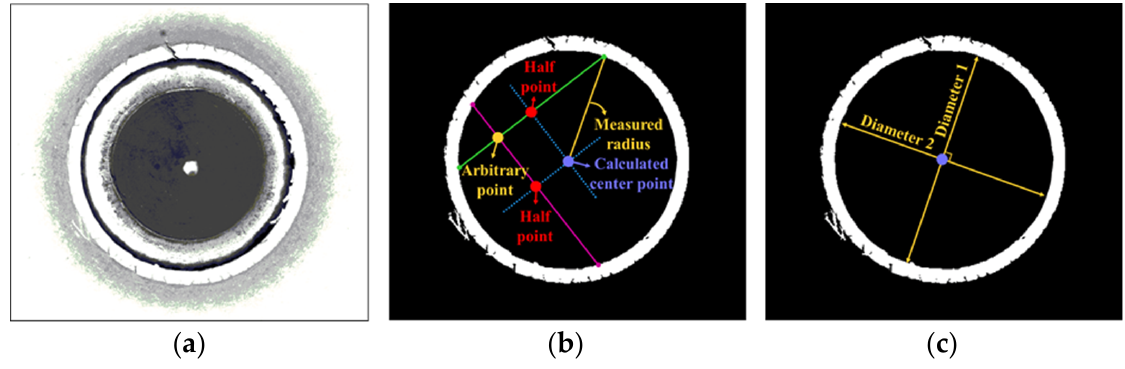
Figure 4. Method for determination of HER: ( a ) captured image from vision camera; ( b ) method for calculating center point at hole; ( c ) measuring standard for defining diameter from hole.